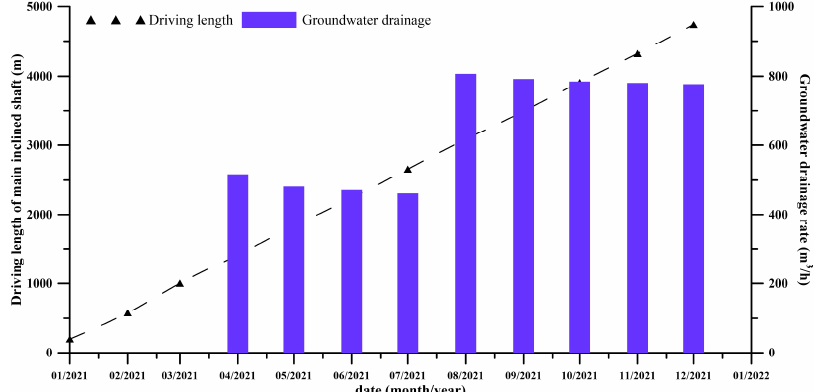
Figure 11. Prediction of the mine water inflow caused by the water-conducting fracture zone under coal mining.